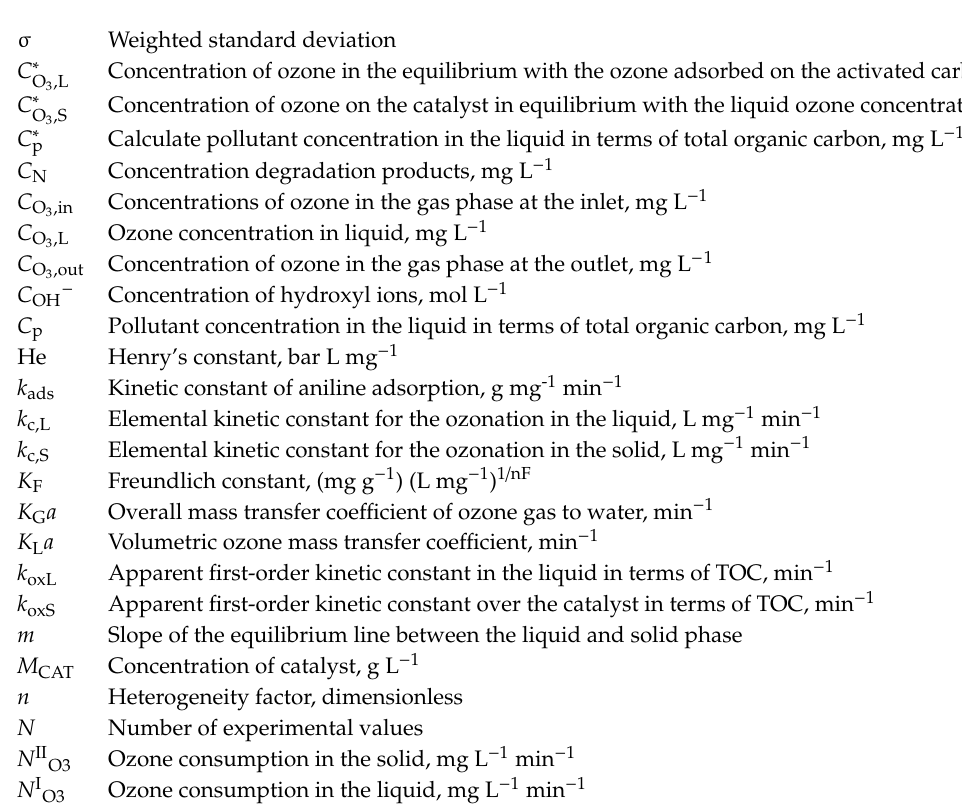
Figure S1: Utilization e ffi ciencies of ozone in a TiO 2 / GAC catalytic system at di ff erent pHs, Figure S2: E ff ect of the ozone dose on the control stage during catalytic ozonation of aniline with the TiO 2 / GAC catalyst, Figure S3: Analysis of some by-products formed during the TiO 2 / GAC ozonation of aniline in terms of TOC, Figure S4: Analysis of the main intermediates in the aniline catalytic ozonation with TiO 2 / GAC in terms of TOC, excluding oxalic and oxamic acid in di ff erent